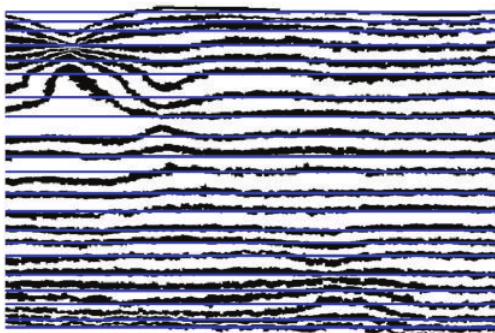
Figure 7: Image of the grating distorted by a defect.